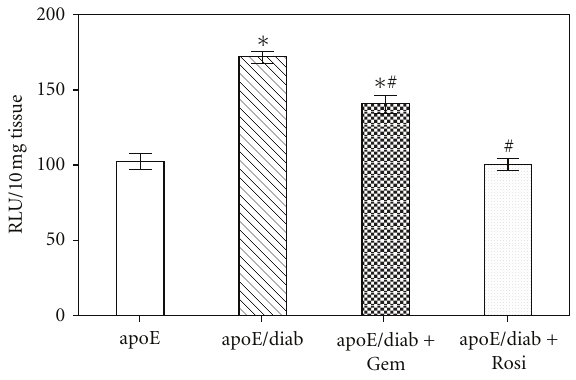
Figure 2: Increased superoxide production in the diabetic vascu- lature is significantly reduced following treatment with PPAR ago- nists, gemfibrozil, and rosiglitazone in streptozotocin diabetic apol- ipoprotein E knockout mice [32,